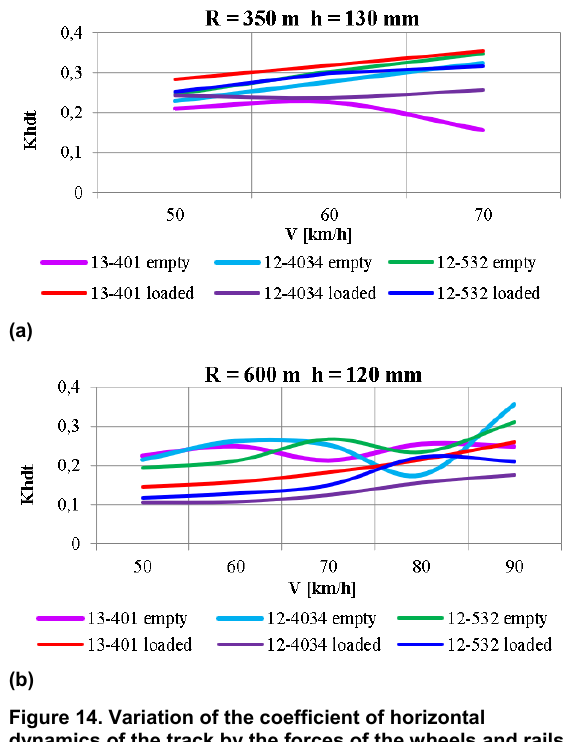
Figure 14. Variation of the coefficient of horizontal dynamics of the track by the forces of the wheels and rails interaction with the motion speed: (a) R=350 m curve; (b) R=600 m curve